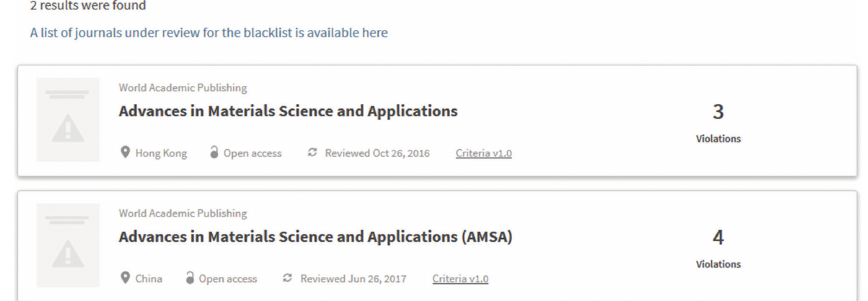
Fig. 7: Two different entries for identical journal Advances in Materials Science and Applications as they appear on Cabell’s blacklist. Screenshot captured on September 8,